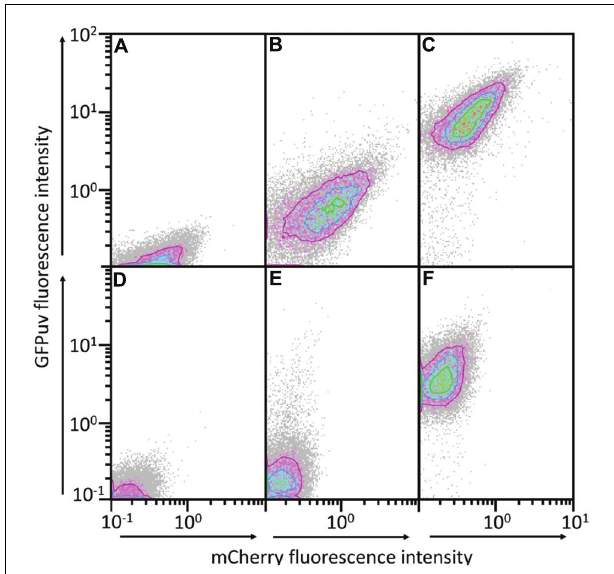
FIGURE 2 | GFPuv and mCherry fluorescence contour plots of populations of B. methanolicus MGA3 transformed with two gene expression plasmids. mCherry and GFPuv fluorescence of B. methanolicus MGA3 (pTH1mp- mcherry ) (A) , MGA3 (pTH1mp- mCherry )(pBV2mp- gfpuv ) (B) , MGA3 (pTH1mp- mCherry )(pUB110Smp- gfpuv ) (C) , MGA3 wild type (D) , MGA3 (pBV2mp- gfpuv ) (E) , and MGA3 (pUB110Smp- gfpuv ) (F) . mCherry fluorescence intensities are depicted on the x axis and GFPuv fluorescence intensities on the y axis. Contour plots of populations of 20000 cells are depicted.